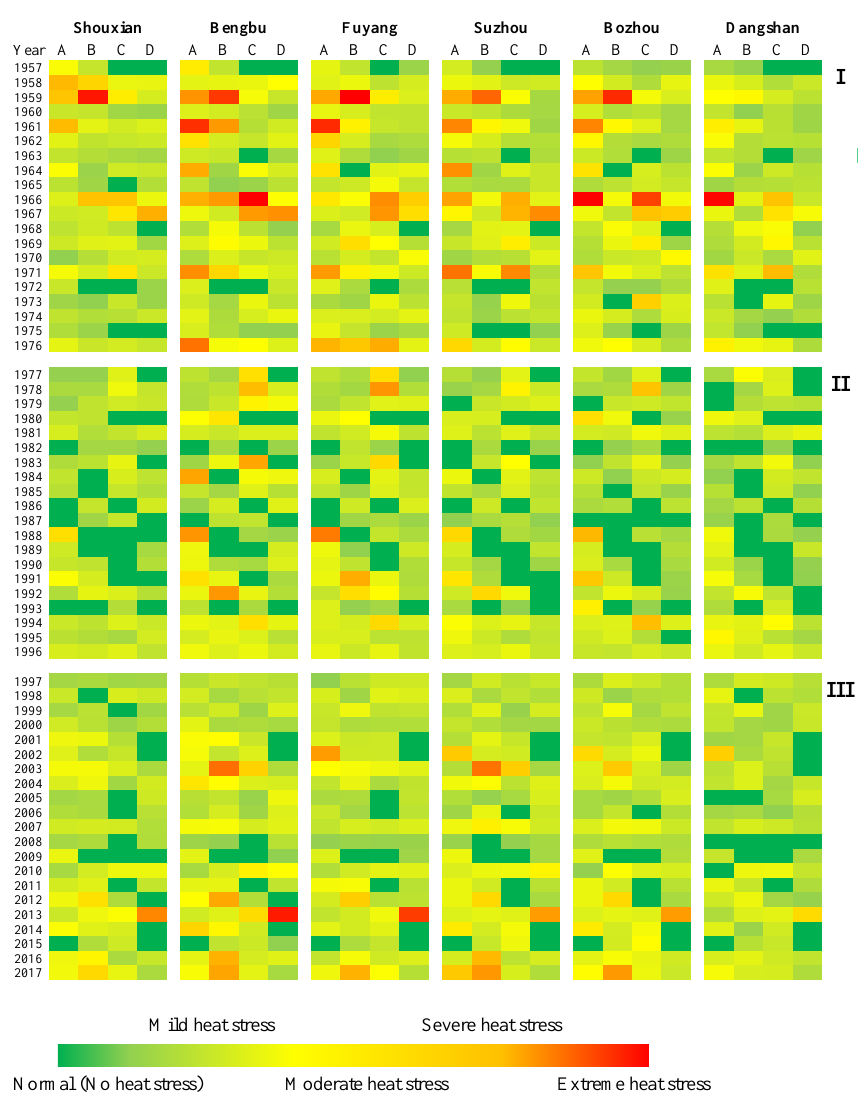
Figure 5. The occurrence, intensity, and distribution of heat events in three successive phases of